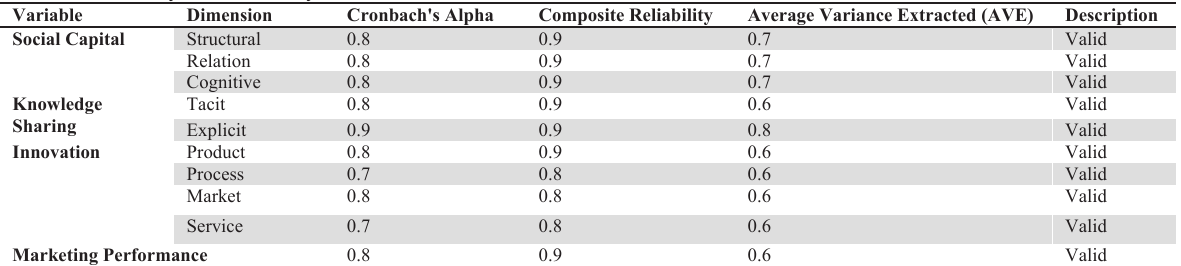
Test of the validity and